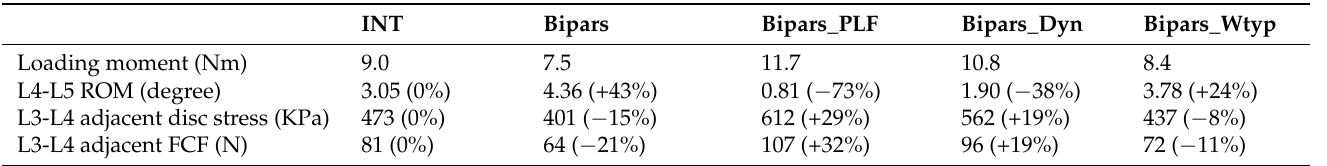
Table 3. ROMs, adjacent disc stress, and adjacent FCF in extension.